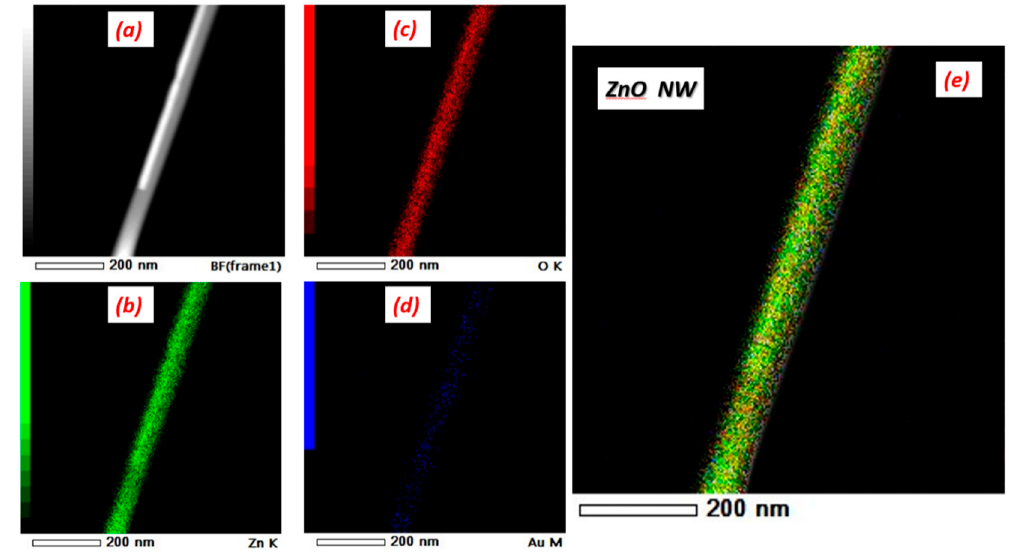
Figure 6. ( a ) shows ZnO transmission electron microscopy (TEM) nanowire image. TEM-energy dispersive x-ray spectroscopy (EDS) elemental mapping image of ( b ) Zn, ( c ) O, ( d ) Au and ( e ) represents the EDS mapping of single ZnO nanowire.